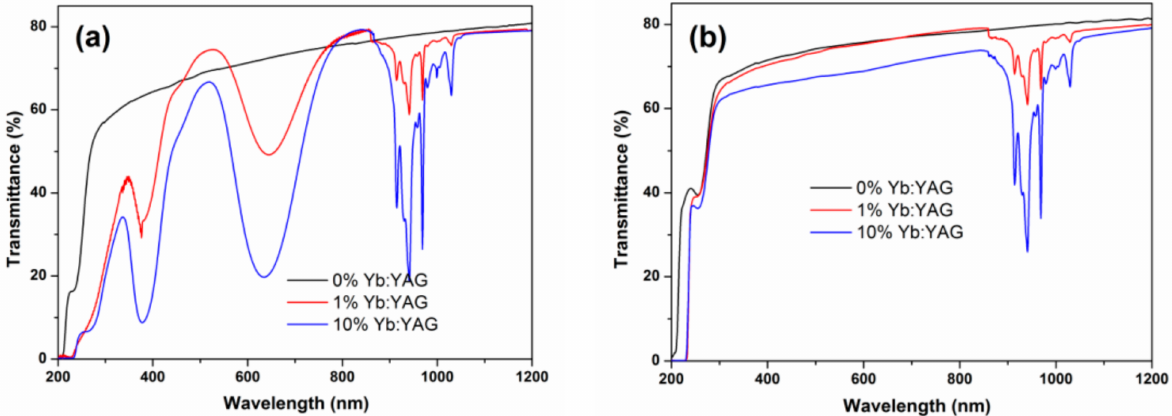
Figure 9. Optical transmittance of (Y 1 − x Yb x )AG ( x = 0, 0.01 and 0.1) transparent ceramics, ( a ) before annealing, and ( b ) after